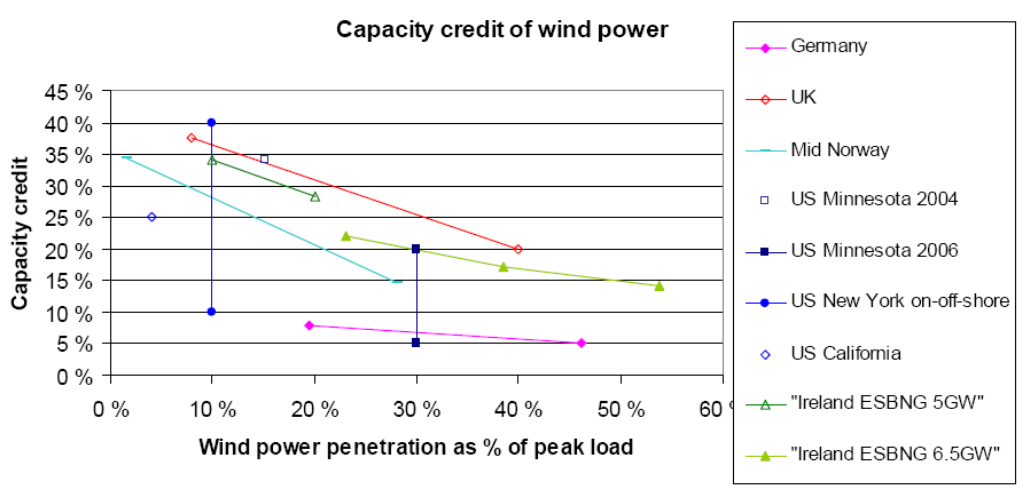
Figure 48. Capacity credit of wind power as a function of wind penetration